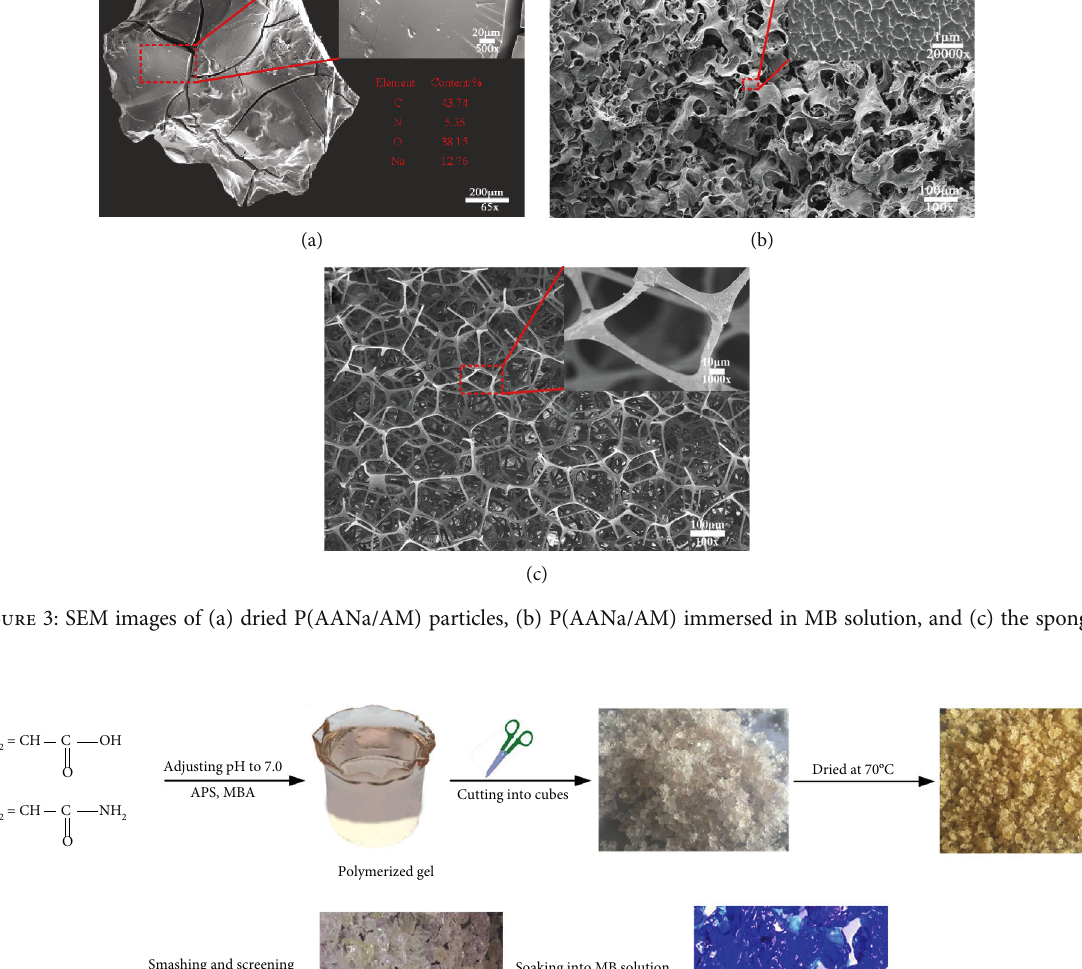
Figure 4: Morphological changes of P(AANa/AM) during the preparation and MB adsorption